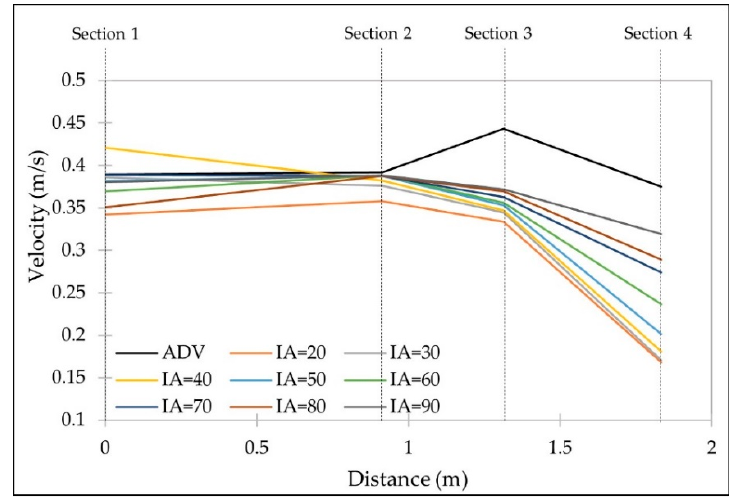
Figure 10. Measured velocities obtained using LSPIV and ADV at Line-A (See Figure 5).